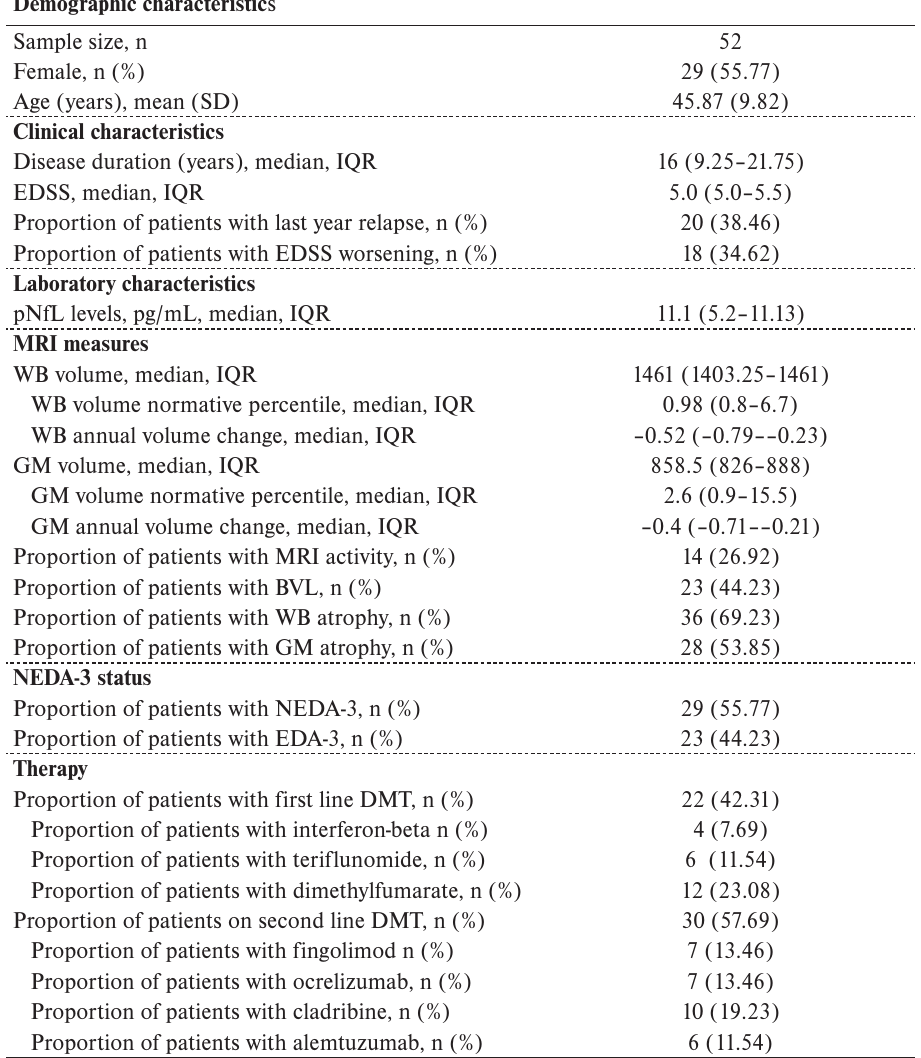
Table 1. Demographic, clinical, laboratory and MRI characteristics of the study